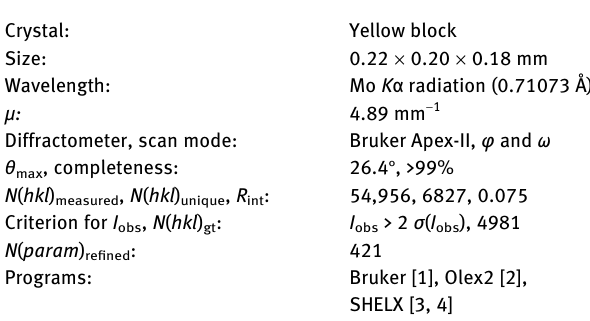
Table  : Data collection and